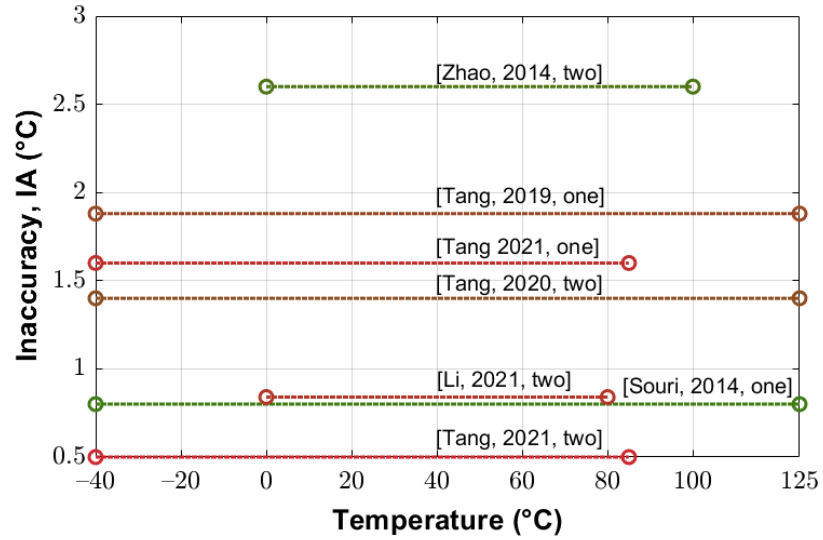
Figure 17. The inaccuracy (IA) versus the temperature range. The reference numbers are labelled close to the markers of the type II sensors. For instance, [Zhao, 2014, two] means the reference ‘s author is ‘Zhao’, and it is published in 2014, and its inaccuracy is obtained after a two-point trim- ming.